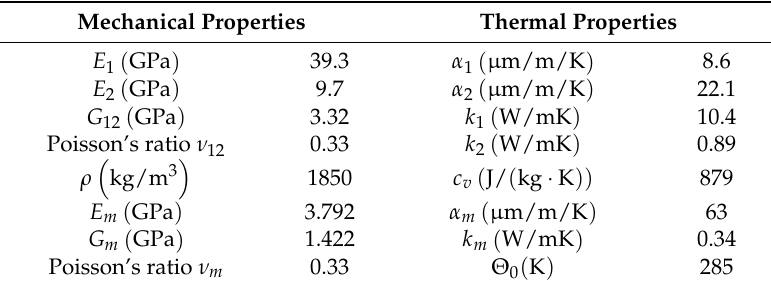
Table 1. Material properties of composite [8].